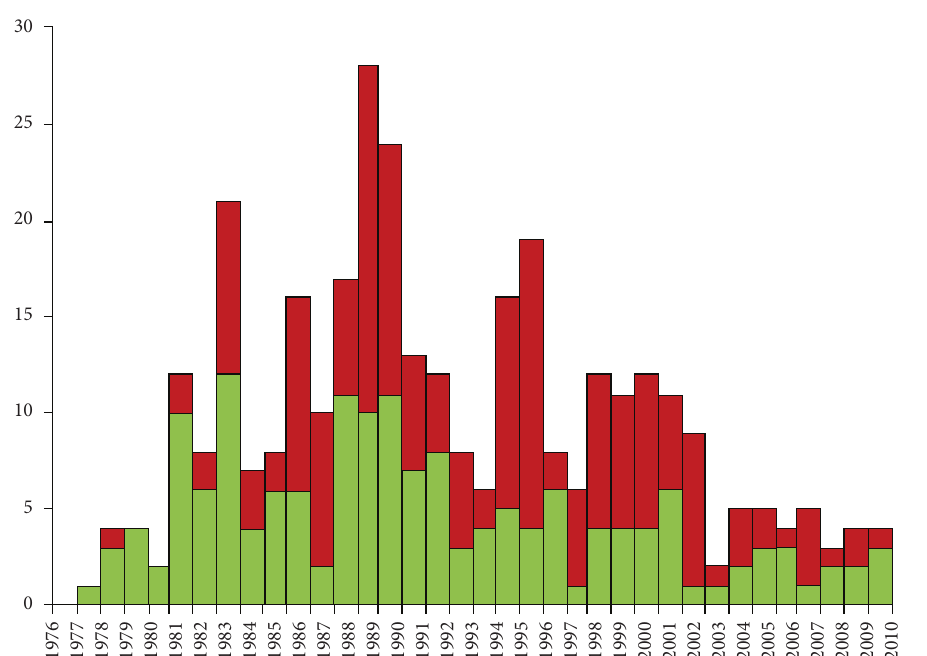
F 2: Yearly incidence of acute diarrhea-associated hemolytic uremic syndrome, from 1976 to 2010. Red bars indicate total number of patients. Green bars represent number of patients requiring dialysis.